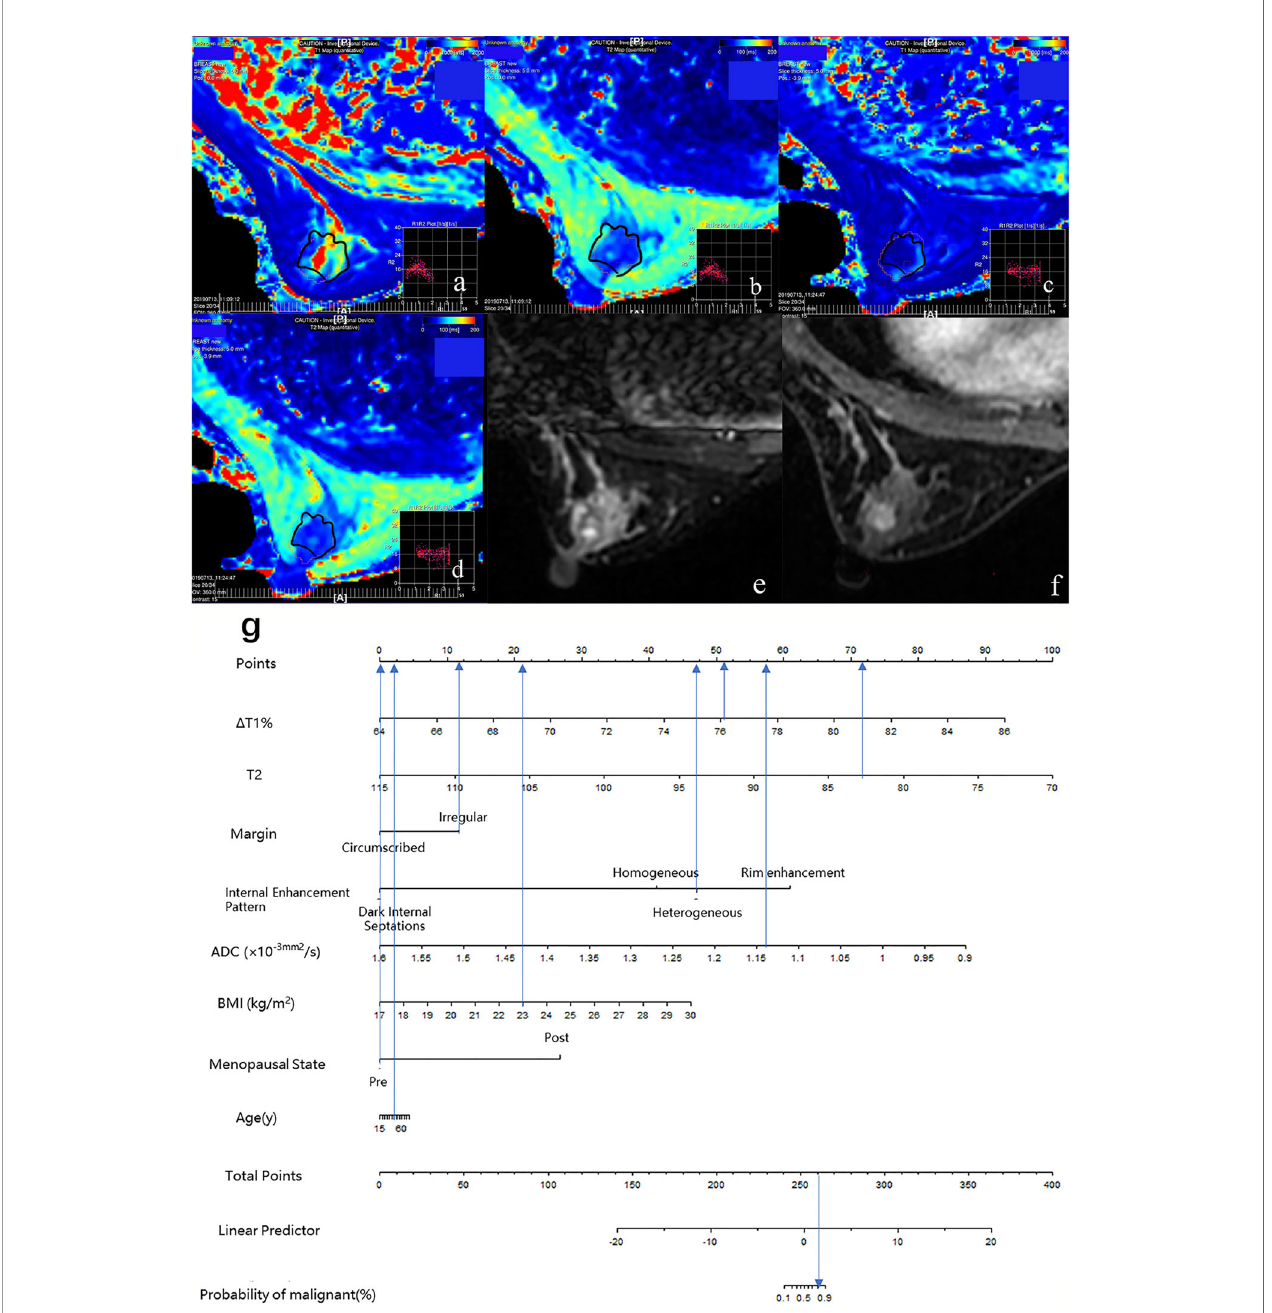
FIGURE 4 | Case 1: Application of prediction model 4 with nomogram in distinguishing breast cancer and benign diseases in BI-RADS 4 lesions. Female, 46 years, premenopausal, BMI = 23, breast cancer, a – g. Image reconstruction with MAGiC, T1 map (A) , T2 map (B) , T1 enhancement map (C) , T2 enhancement map (D) , T2WI (E) , DCE (F) , Nomogram (G) . T1 = 1,349.77 ms, T1+ = 323.05 ms, D T1% = 76.07, T2 = 83.01 ms, T2+ = 78.03 ms, D T2% = 6.00%, ADC = 1.14 × 10 − 3 mm 2 /s, irregular margin, and heterogeneous internal enhancement pattern. Total points = 261.80. Probability of malignant =